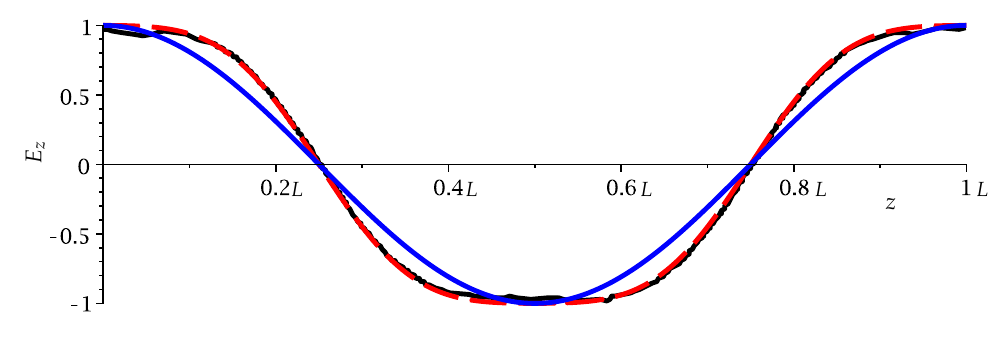
Figure 9. Field profile shaping in a metallic waveguide containing a 4 × 4 array of infinitely long wires of varying radii and with L = 80.61 mm. The simulated field profile E z itself is normalised and shown with solid black lines, and is compared with the ideal Mathieu function profile shown as a dashed red curve, with a sinusoid shown in blue as a reference. In the simulation, CST gave the maximum longitudinal field as 3.28 × 10 7 Vm − 1 .